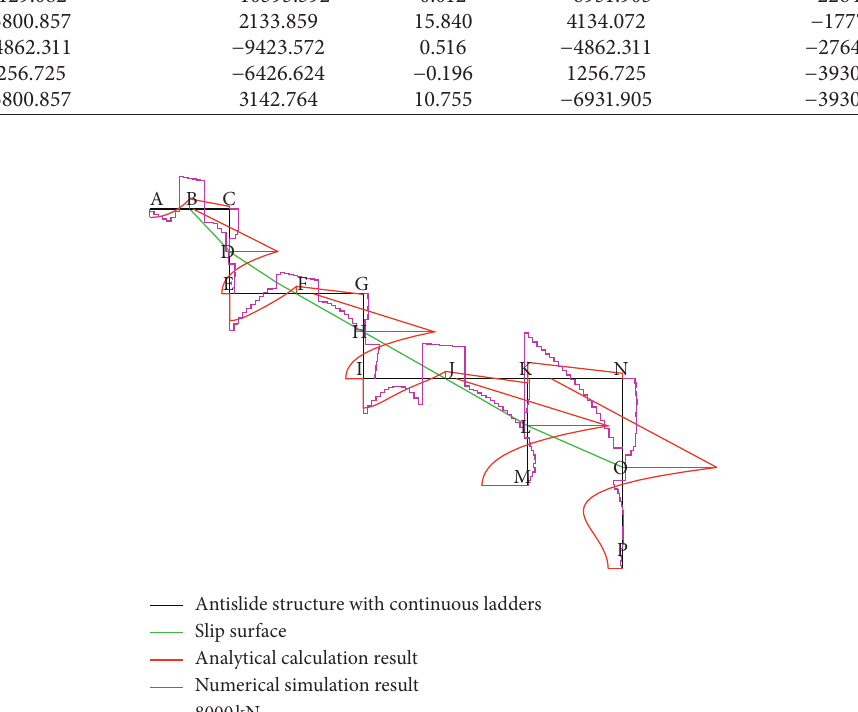
Figure 15: A comparative figure of the shear force of the ASCL. The black lines represent the initial shape of the ASCL, and the green lines represent the slip surface. Taking the initial shape of the ASCL as a standard, the red lines represent the shear force of the analytical calculations, while the pink lines represent the shear force of the numerical